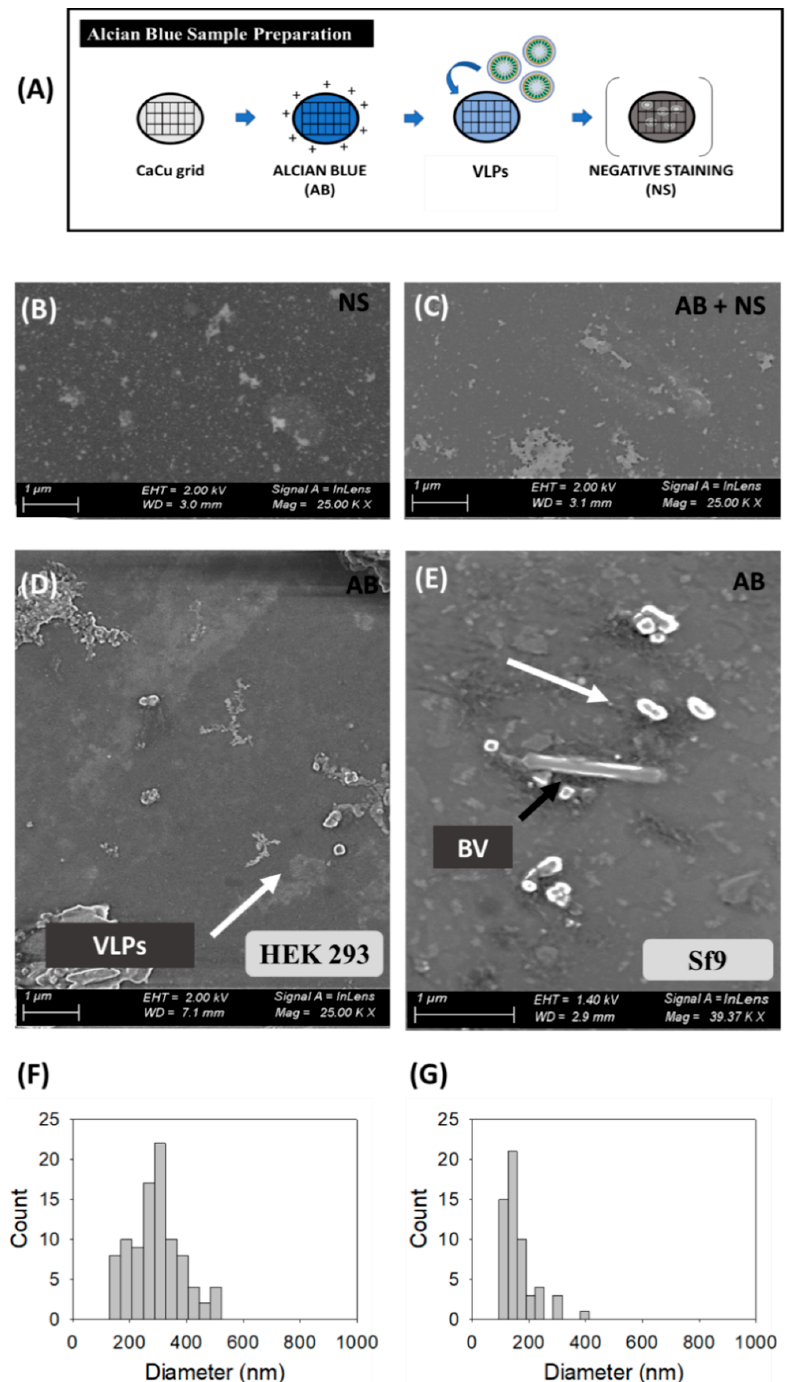
Figure 2. Scanning electron microscopy analysis of HIV-1 Gag-eGFP VLPs produced in HEK 293 and Sf9 cell lines harvested at 72 hpt and 72 hpi, respectively. ( A ) Sample preparation protocol; ( B – E ) Comparison of different sample preparation methods: ( B ) negative staining (NS) ( C ), combining Alcian Blue solution and negative staining (AB + NS) on HEK 293 supernatants; ( D ) Supernatant from transfected HEK 293 cells and ( E ) supernatant from BV infected Sf9 cells treated with Alcian Blue (AB) for 1 min in a Holey carbon 200 mesh grid. ( F – G ) PSD analysis of HEK 293 and Sf9 supernatants, respectively. White arrows indicate the presence of nanoparticles in HEK 293 and Sf9 supernatants and black arrows indicate the presence of BV. Negative controls were analyzed using the same conditions as in VLP samples (Supplementary Materials S1).